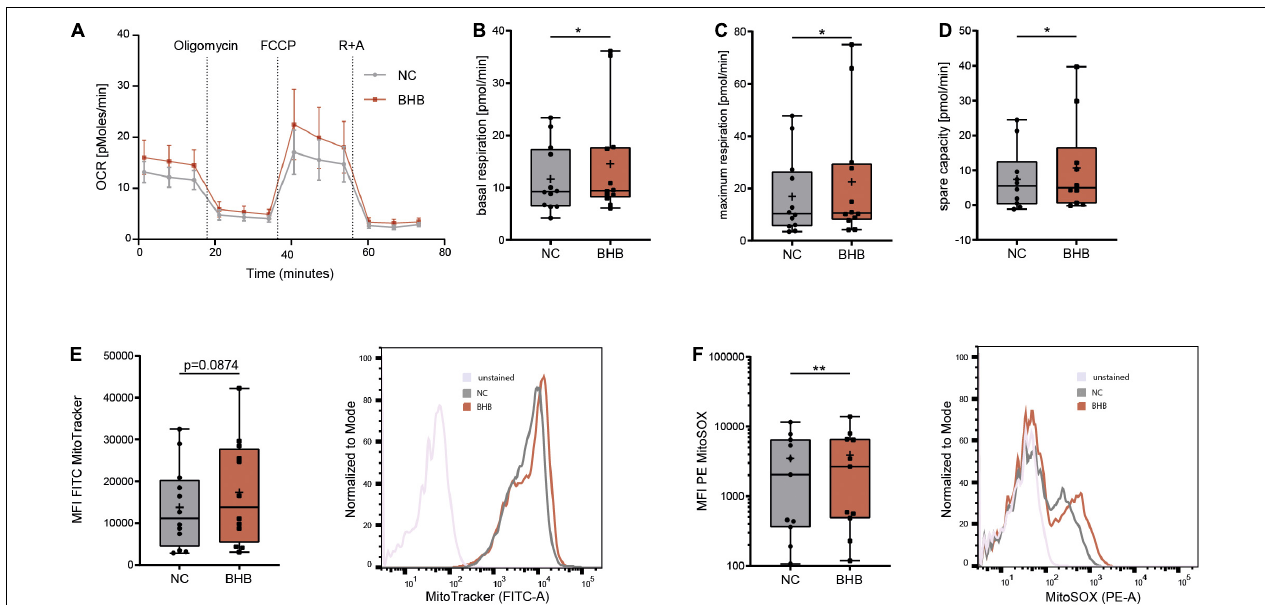
FIGURE 2 | Beta-hydroxybutyrate shifts human T-cell metabolism toward oxidative phosphorylation enabling higher mROS production. Human peripheral blood mononuclear cells (PBMC) were cultivated for 5 days in RPMI containing 80 mg/dl glucose (NC) and supplemented with 10 mM D/L-beta-hydroxybutyrate (BHB). T-cell stimulation was performed through CD3/CD28 Dynabeads at a bead:cell ratio of 1:8. CD8 + T cells were isolated via magnetic cell separation. (A–D) Oxygen consumption rate [OCR] (A) , basal (B) , maximum (C) and spare respiratory capacity (D) were measured using a Seahorse HS mini Analyzer, n = 5 individual patient samples, each performed in 2–3 technical replicates. (E) Mitochondrial mass determined via MitoTracker green, indicated by MFI FITC in human CD8 + T cells, n = 12 individual patient samples. Histogram depicting exemplary change of MitoTracker green. (F) Quantification of mitochondrial superoxide production using MitoSOX, displayed as MFI PE in human CD8 + T cells, n = 11 individual patient samples. Histogram depicting exemplary change of MitoSOX fluorescence. * p < 0.05, ** p <